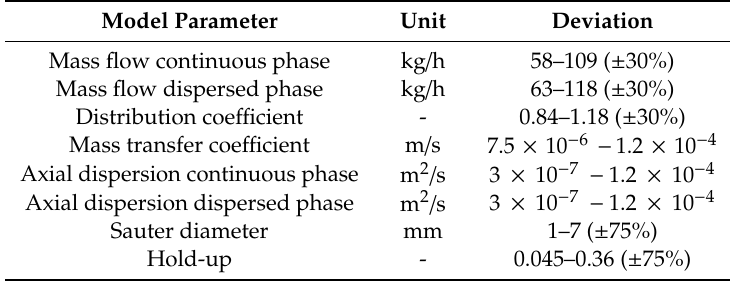
Table 2. Axial dispersion model parameters for the one-parameter-at-a-time sensitivity